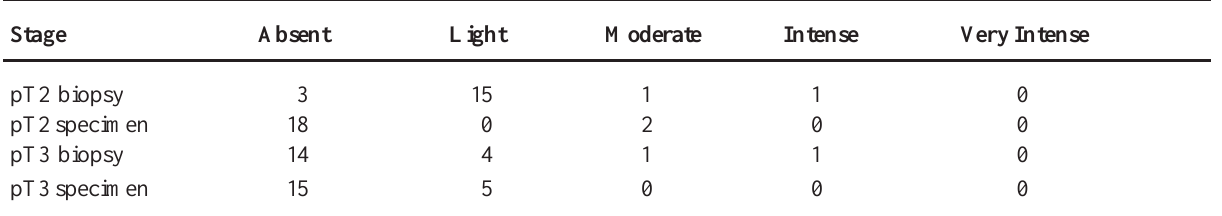
Table 7 – Number of patients grouped in the different categories, based on the synaptofisin expression in both stages (pT2 and pT3).